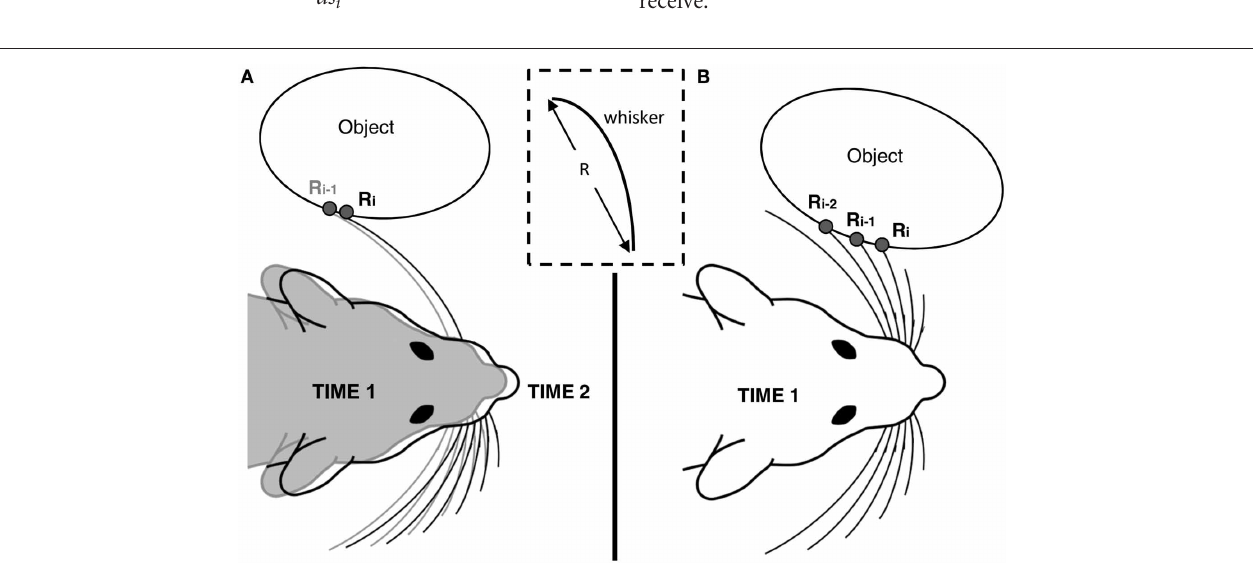
FIGURE 2 | Computing slope and curvature over multiple vibrissae. The inset in the middle of the figure emphasizes that radial distance R is measured from the base of the whisker to the point at which the whisker contacts the object. (A) In the single whisker method, we imagine that the rat compares sensory data acquired from a whisker with the data it remembers having acquired on the previous timesteps. The rat shaded